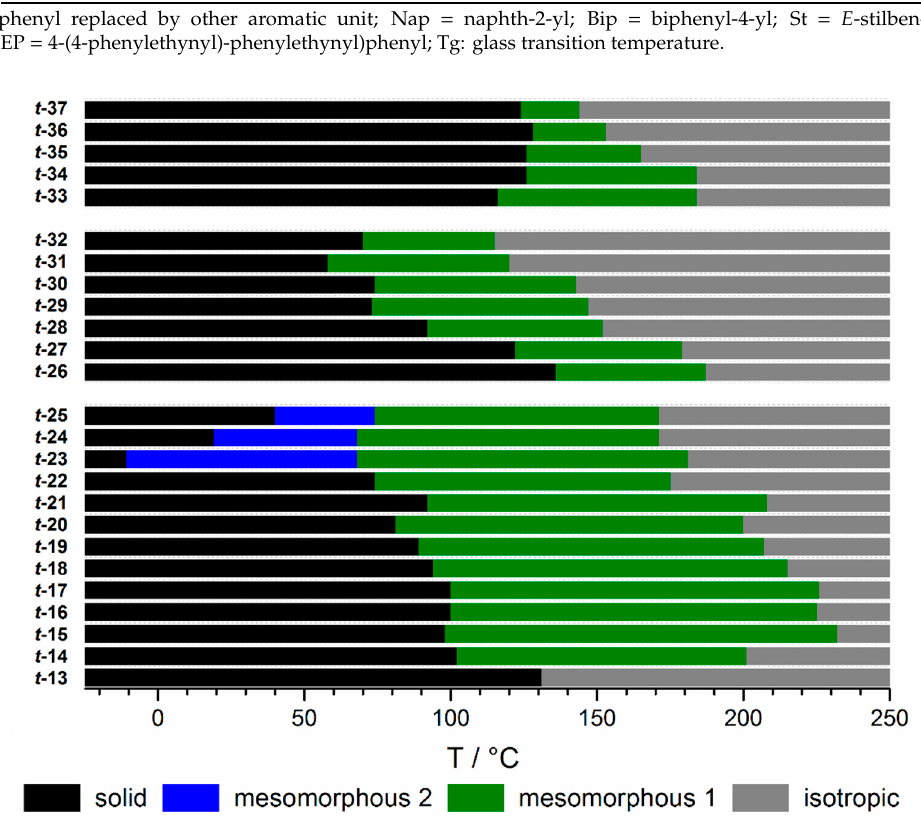
Figure 2. Phase behavior of 3,4-di- ( t -13– t -25 ), 3,5-di- ( t -26– t -32 ) and 3,4,5-trialkoxyphenyl ( t -33– t - 37 )-substituted t -TTTs depending on chain